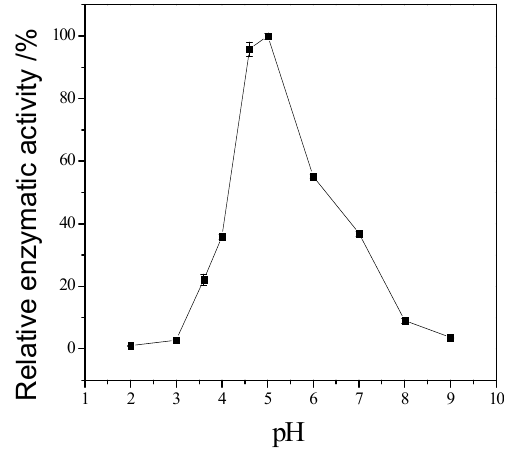
Figure 6. Effect of reaction pH on enzymatic activity.